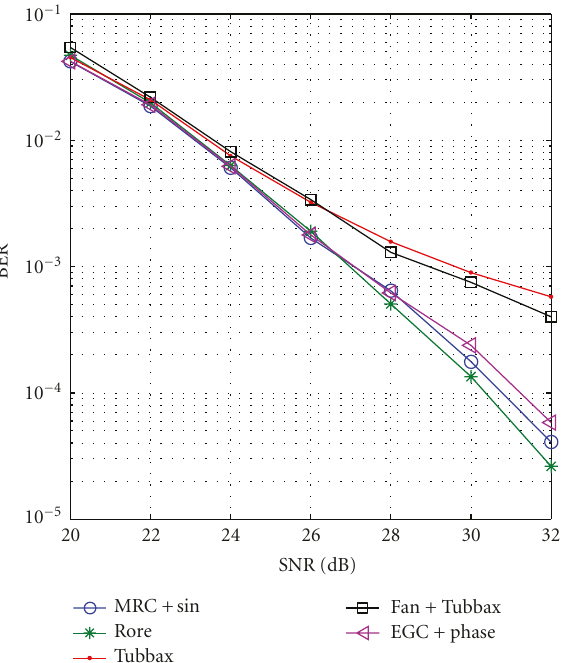
Figure 7: BER at SNR = 22 dB versus normalized CFO in the presence of small random mismatch which is uniformly distributed in [0,1] dB for gain mismatch and [0,4 ◦ ] for phase mismatch.